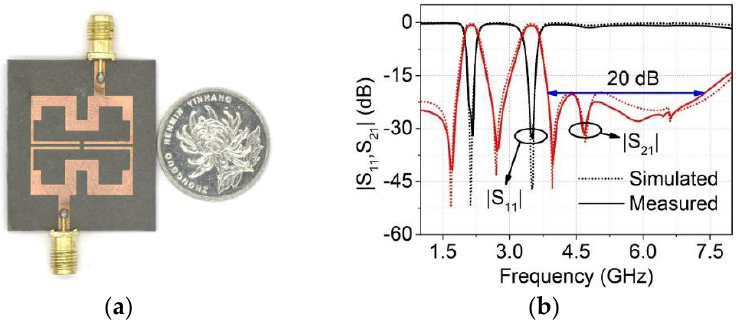
Figure 7. Manufacture and measurement of the dual-wideband BPF. ( a ) Photograph of the dual- Figure wideband BPF; ( b ) Simulated and measured |S 21 , S 11 | response of the dual-wideband BPF.